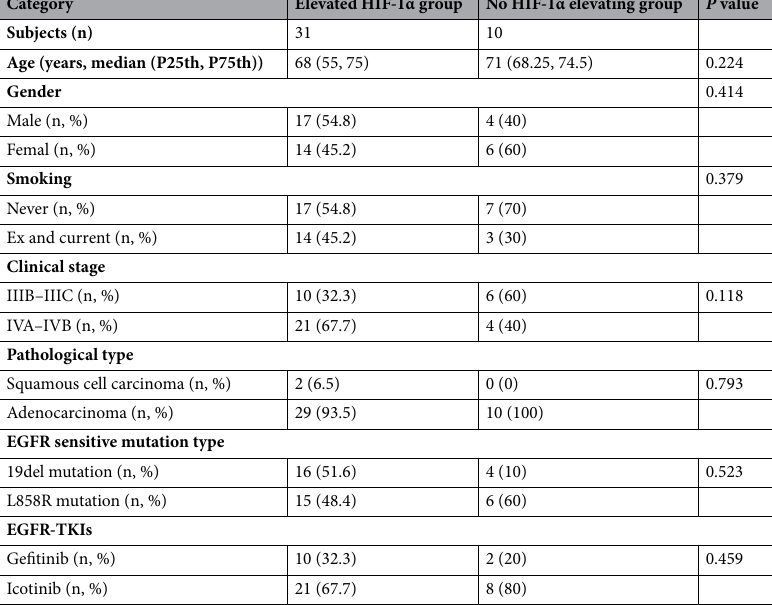
Comparison analysis P value